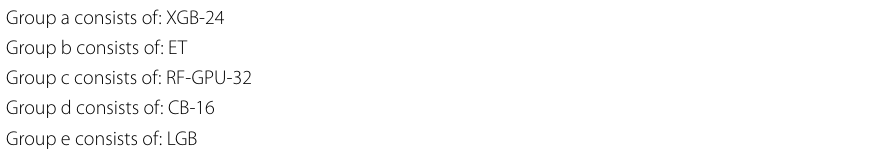
Table 21 HSD test groupings after ANOVA of AUC for the CLF factor